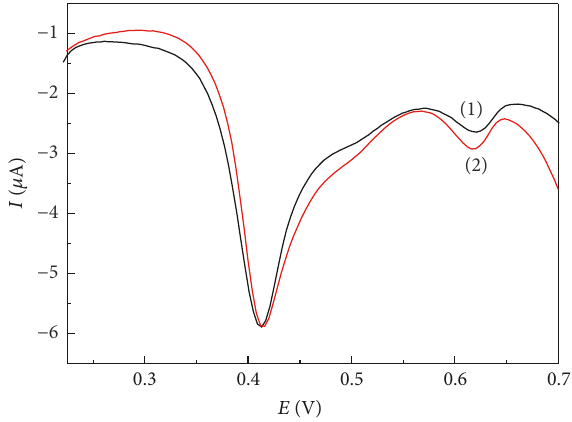
Figure 6: DPV curves of the ERGO/GC electrode before and after the addition of 5 𝜇 M trans -resveratrol for the red wine